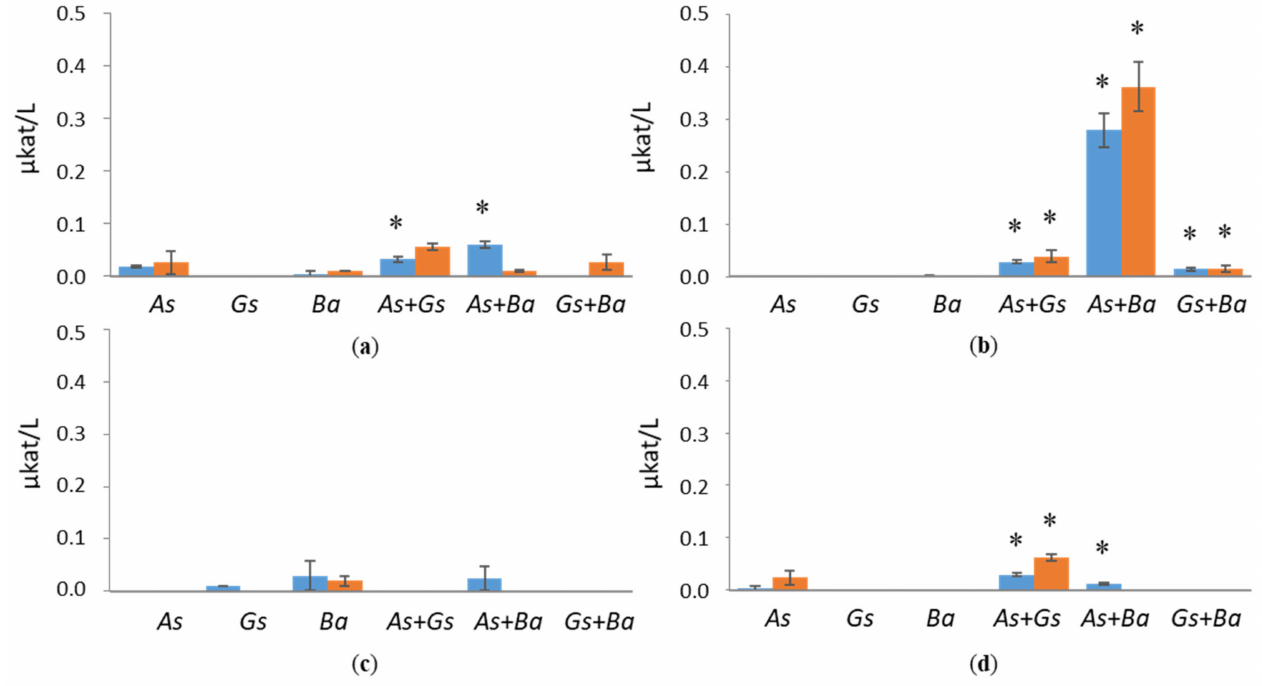
Figure 10. Laccase (Lcc) activities at early (day 10, marked in blue) and late time points (day 24, marked in red) in single and co-cultivation on ( a ) birch, ( b ) spruce, ( c ) pine wood and ( d ) Avicel. As = A. sinuosa , Gs = G. sepiarium , Ba = B. adusta , As + Gs = A. sinuosa and G. sepiarium , As + Ba = A. sinuosa and B. adusta , Gs+Ba = G. sepiarium and B. adusta . Error bars refer to standard deviation (SD) ( n = 3). * indicates statistical difference among single and co-cultivations ( p <